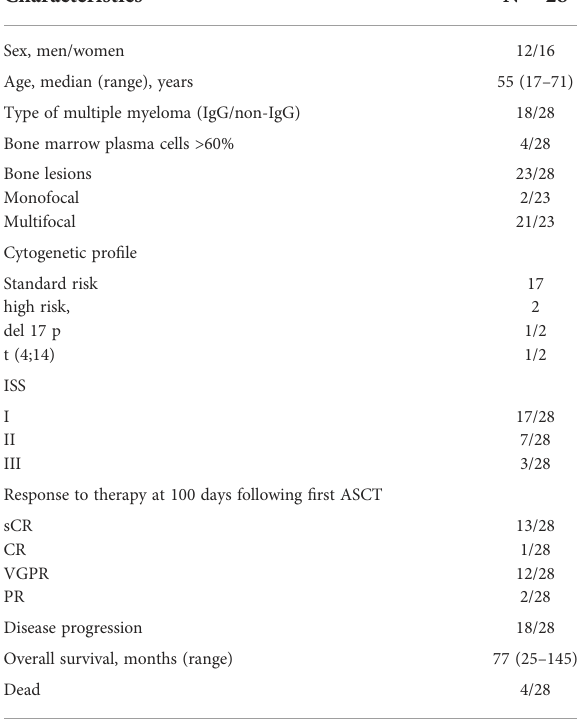
TABLE 2 Patient characteristics.